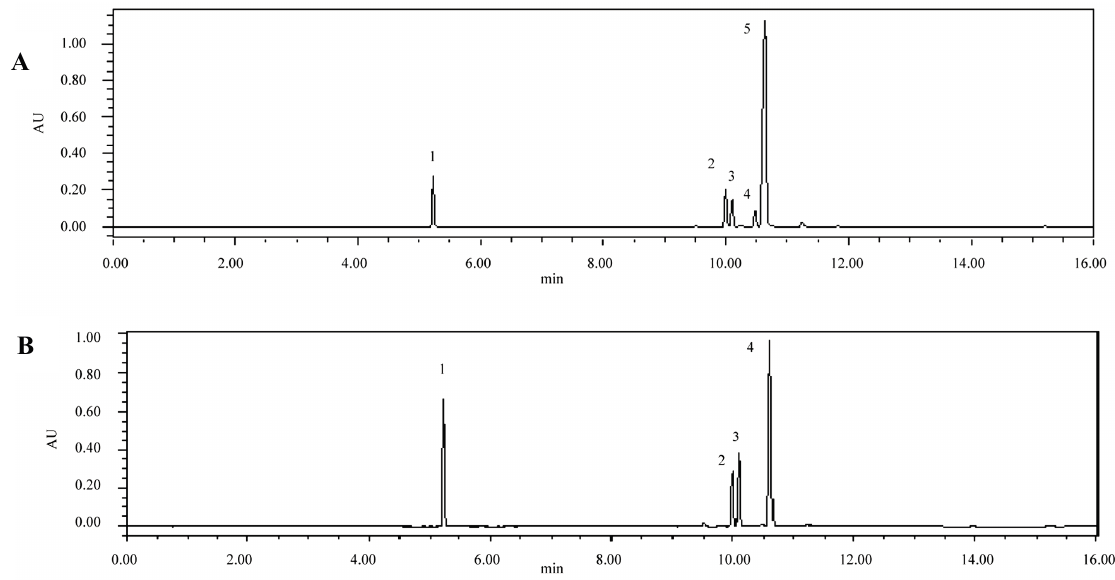
Figure 1. The UPLC-PDA chromatogram of ferulic acid and phthalides in Angelica sinensis by UV at 261 nm ( A ), 281 nm ( B ); Peaks: (1) Ferulic acid; (2) Senkyunolide A; (3) n -Butylphthalide; (4) Ligustilide; (5) Butylidenephthalide.